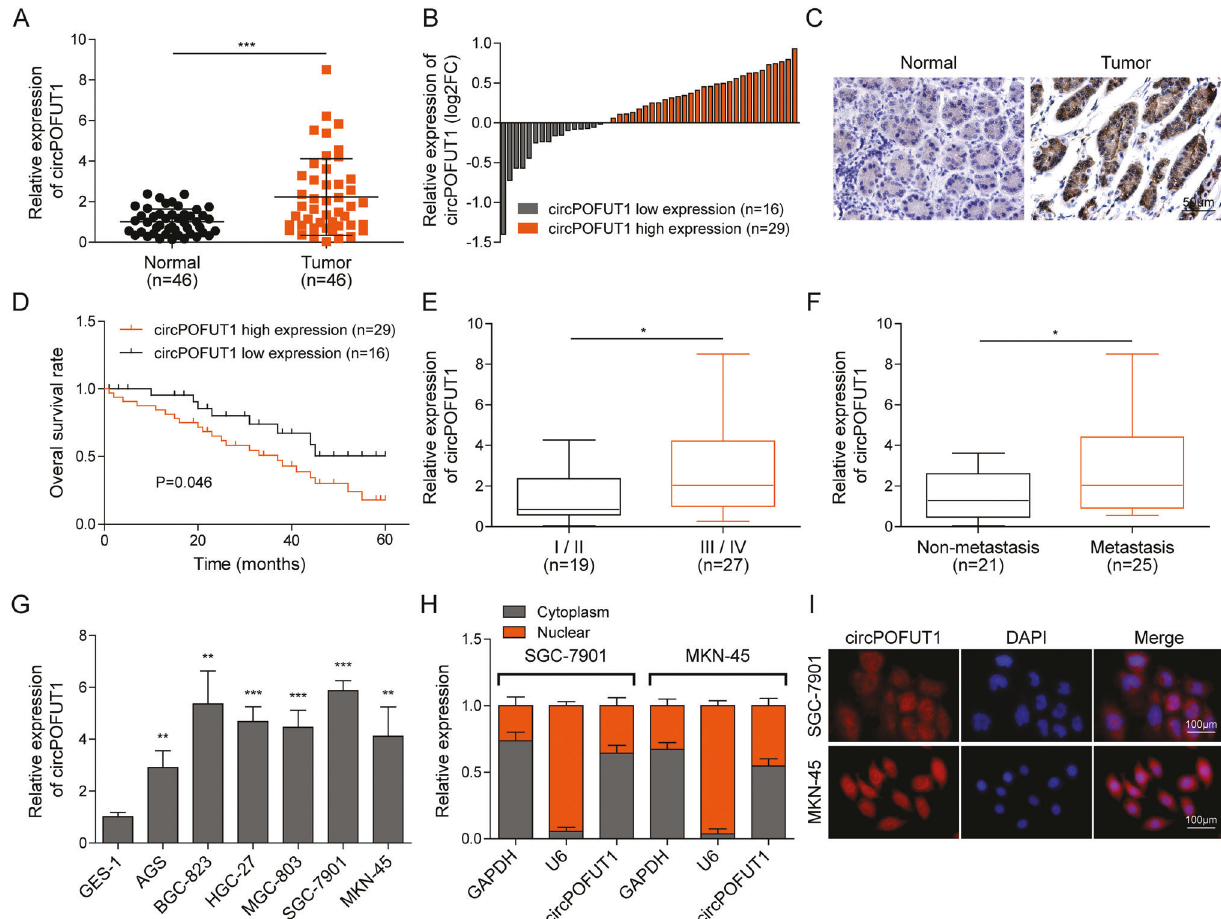
Fig. 1 CircPOFUT1 was highly expressed in GC tissues and cells. A RT-qPCR analysis of circPOFUT1 ( n = 46). B GC patients were divided into two groups, low- ( n = 16) and high-expression ( n = 30) groups. C CircPOFUT1 expression in normal and GC tissues was analyzed by ISH (scale bar, 50 µm). D The survival of patients. E The expression of circPOFUT1 in tumors at stage I/II ( n = 19) and III/IV ( n = 27). F The expression of circPOFUT1 in tumors from patients with non-metastatic ( n = 21) and metastatic cancers ( n = 25). G RT-qPCR analysis of circPOFUT1 ( n = 3). H RT-qPCR analysis of circPOFUT1 in cytoplasmic and nuclear fractions ( n = 3). I The localization of circPOFUT1 (Red) was validated by RNA- FISH staining (scale bar, 100 µm; Nuclei, Blue). * P < 0.05, ** P < 0.01, and *** P < overexpression of circPOFUT1 promoted GC cell migration and invasion (Fig. 3H, I). Our fi ndings suggested that circPOFUT1 promoted GC cell malignant phenotypes.